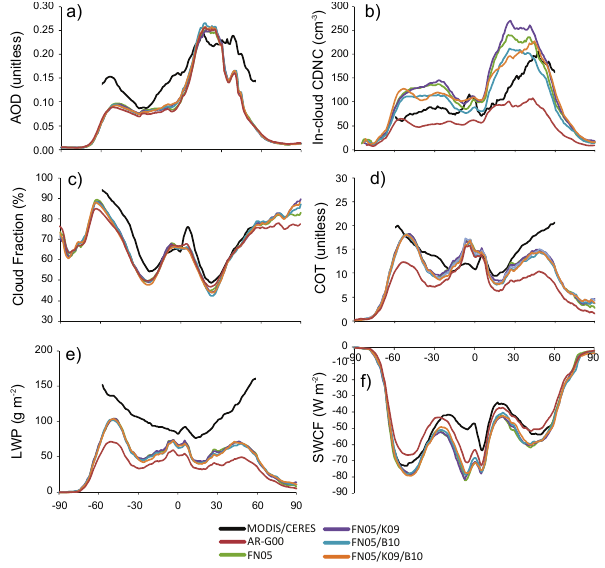
Figure 1. Annual-average zonal-mean (a) aerosol optical depth, (b) low level cloud droplet number concentration (MODIS values derived from Bennartz (2007) and CESM/CAM5 values averaged between 960 and 850 mb), (c) cloud fraction, (d) cloud optical thickness, (e) liquid water path, and (f) shortwave cloud forcing de- rived from satellites and predicted by